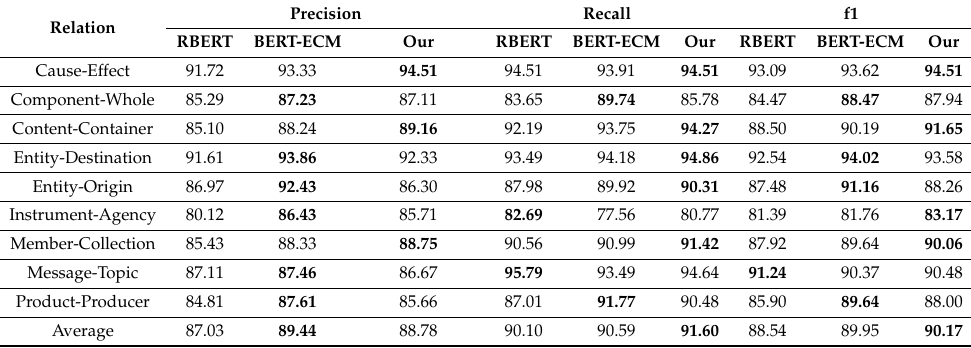
Table 8. Comparison of precision, recall, and f1 score of our model with RBERT model and BERT-ECM on the SemEval-2010 Task 8 dataset.